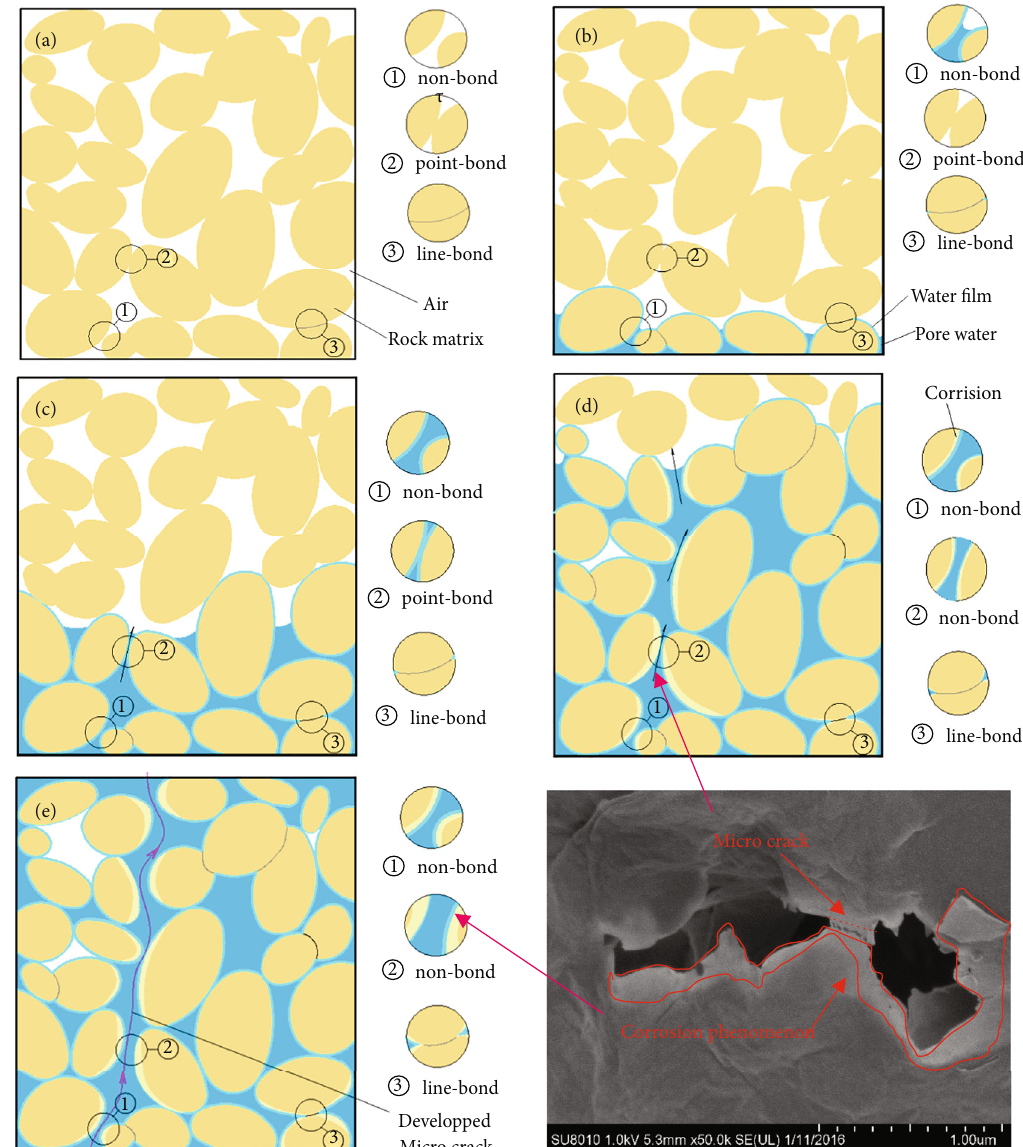
Figure 10: Water absorption-induced strength damage process of the